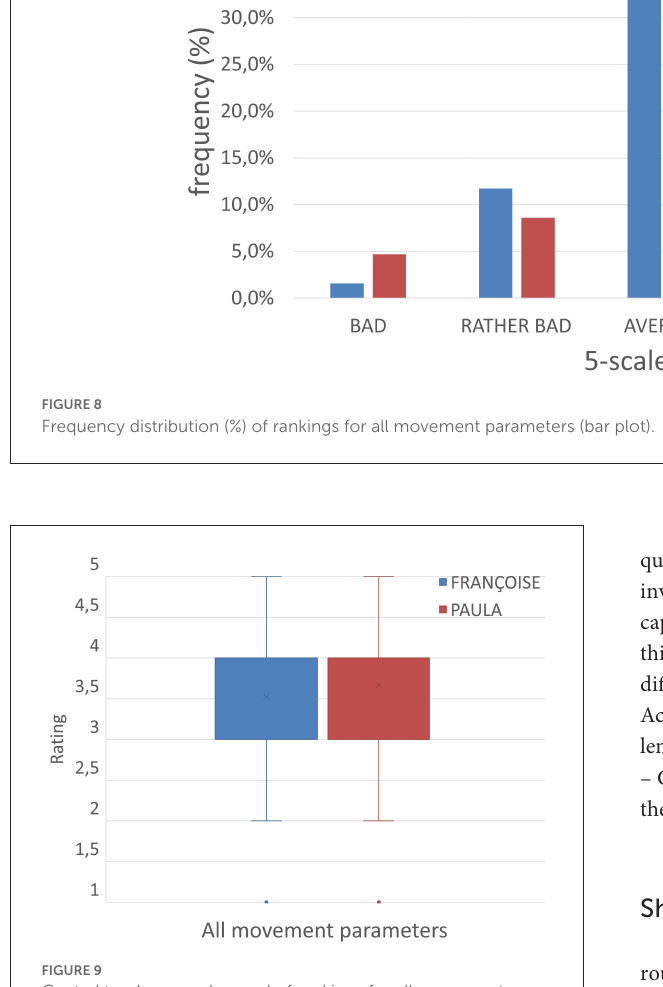
FIGURE9 Central tendency and spread of rankings for all movement parameters for both avatars.